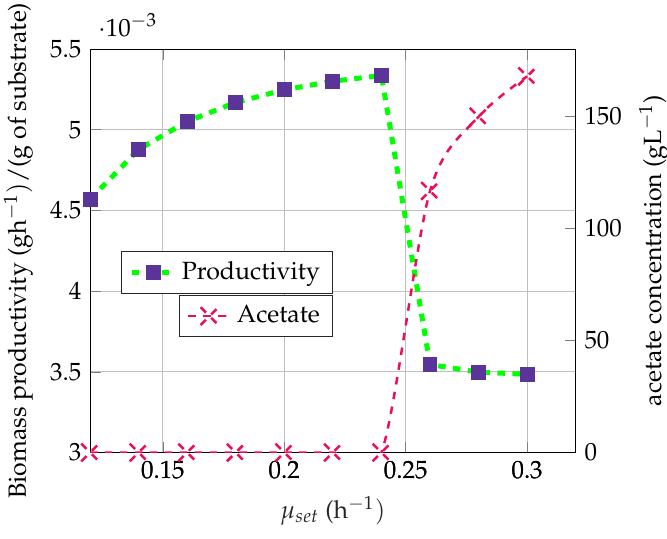
Figure 4. Biomass productivity (green) and acetate production (red) for different µ set